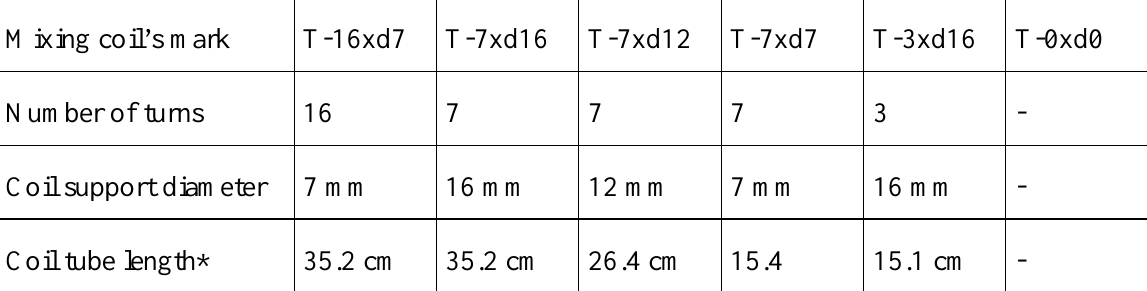
Table 3. Characteristics of mixing coils designed from the polymeric